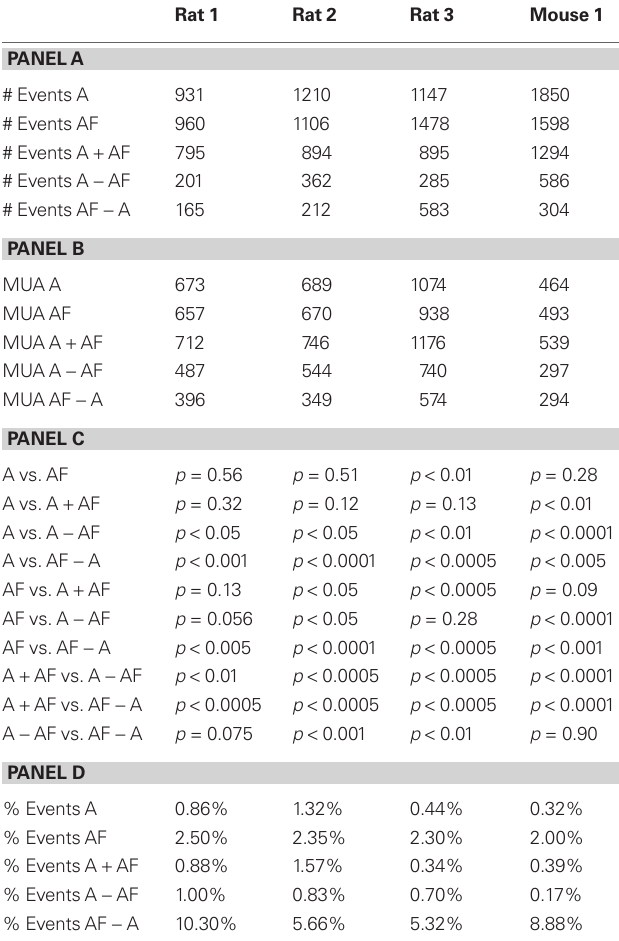
Table 3 | Comparison of AMP “set A” and AMP + FM “set AF” based ripple detection. (A) The number of ripple events in each set (see Figure 9A ). (B) Average multi-unit rate during ripples in each set. (C) Comparison of multi-unit rate distributions for all combination of sets in Panel (A) of this table. Signifi cant differences between distributions are determined by a p -value threshold of 0.05. (D) Percentage of events with a positive gamma-ripple